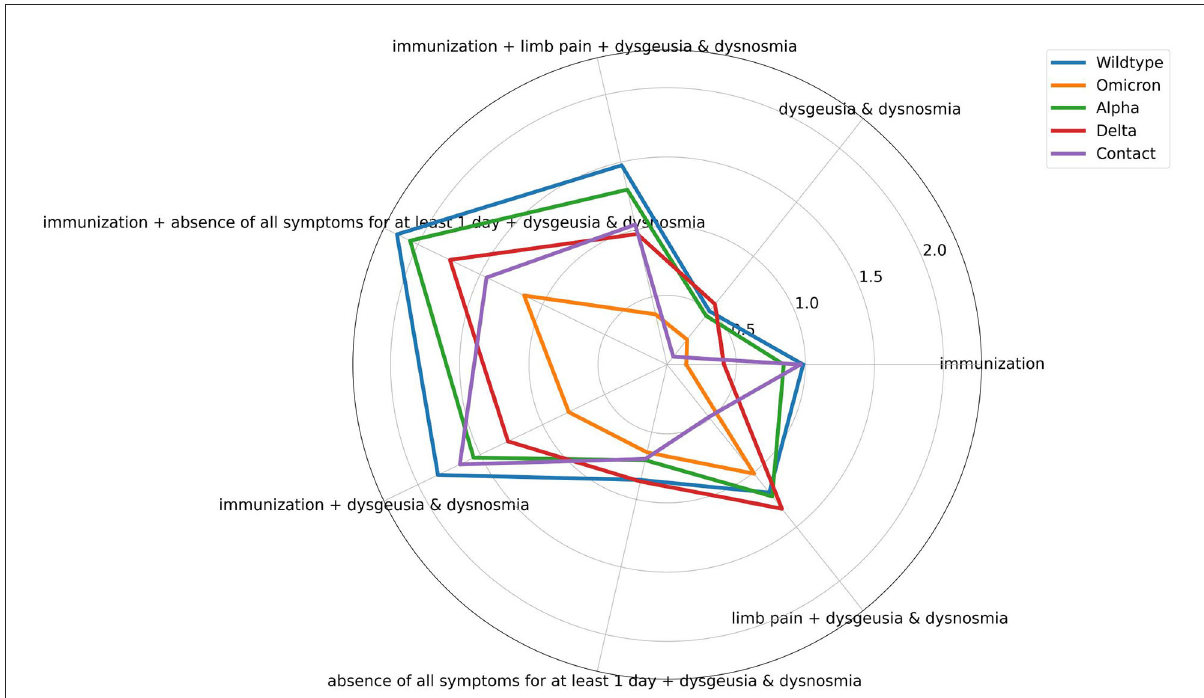
FIGURE4 Spider plot of averaged symptom combinations for the different prevailing dominant virus variants and contact persons revealed from the decision tree. Symptoms can range from [0,1], whereby 0 represents the absence and 1 the occurrence of the symptom. Immunization can range from [0, 1], whereby 1 represents no immunization, and 0 means any type of vaccination regardless of the